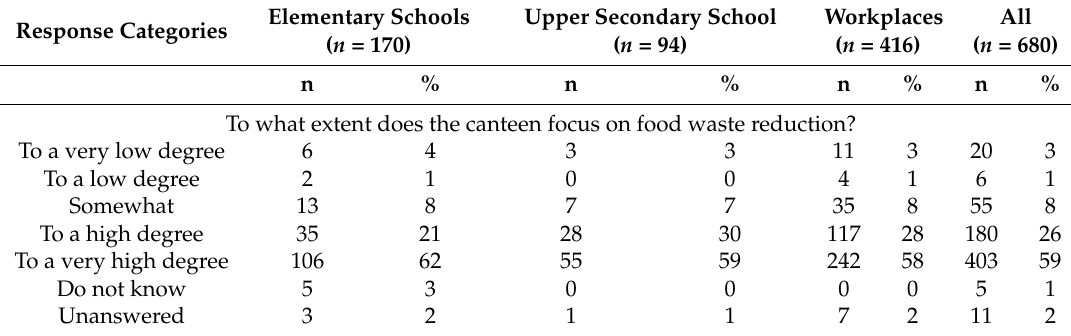
Table 5. Canteens’ focus on food waste reduction.